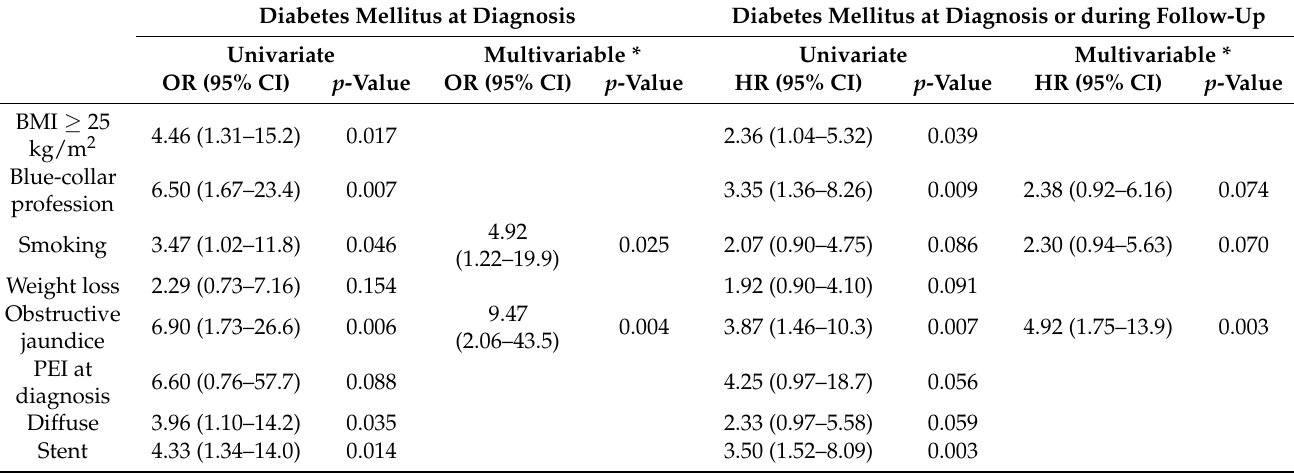
Table 2. Factors associated with DM at univariate and multivariable analysis.